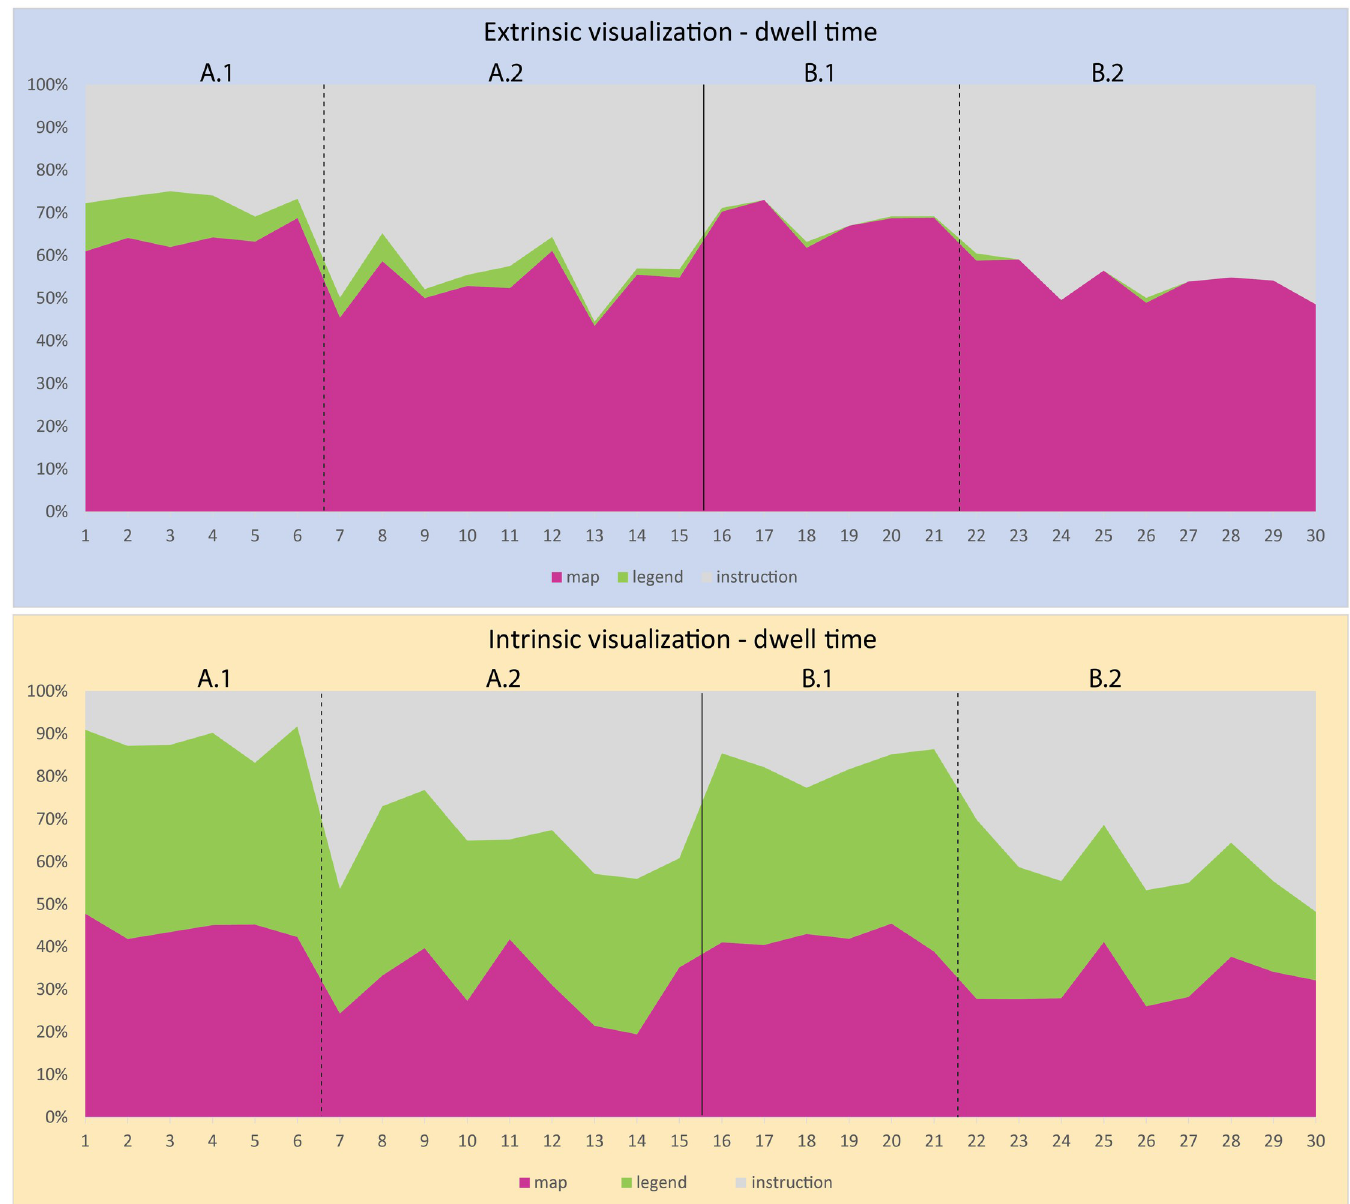
Fig 12. Dwell time on AOI (%) for the extrinsic visualization (top) and intrinsic visualization (bottom). Extrinsic visualization–proportion of dwell time at AOI in single items; (top); Intrinsic visualization–proportion of dwell time at AOI in single items